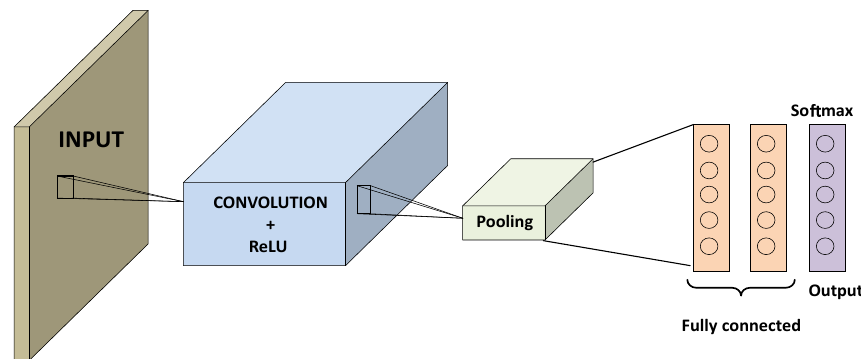
Figure 2. Basic architecture of a Convolutional Neural Network (CNN).